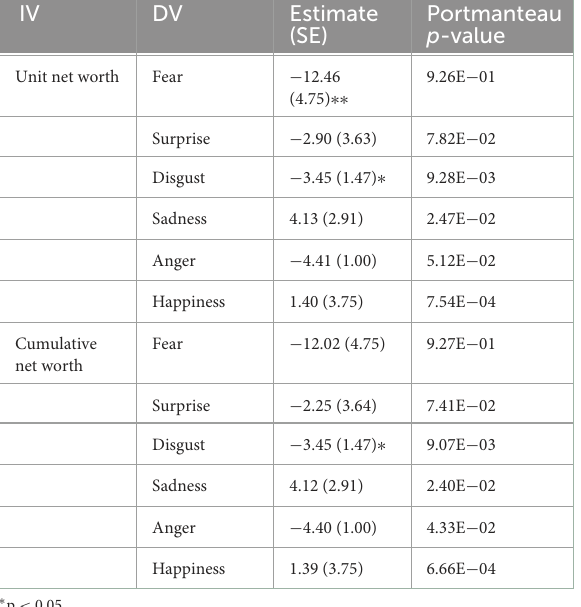
Portmanteau p -value (SE)